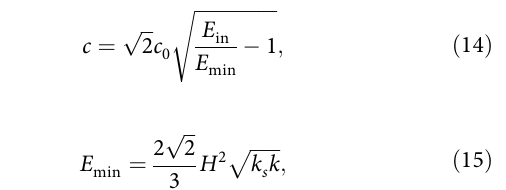
Fig. 5a we focus on an array with N = 10 double shells identical to those considered in Fig. 3b, with c and report the evolution of c during propagation for different values of input energy, assuming β = 2.5 kg/s. Notably, we fi nd that the prediction of the continuum model (dashed lines in Fig. 5) nicely agree with the numerical results (continuum lines) up to the fi fth shell for moderate and large values of the input energy. Beyond the fi fth shell, the free boundary starts to play an important role and this cannot be captured with our continuum model (since we assume the array to be in fi nitely long). Once again, we observe that by increasing the amount of energy supplied to the fi rst unit, pulses with higher velocity are initiated. However, irrespectively of E in , for the level of dissipation present in our structure all transition waves are found to stop after the inversion of the fi rst few units in the absence of favorable end effects. Next, we use our analytical model to predict the fi nite propagation distance in systems with a nonzero